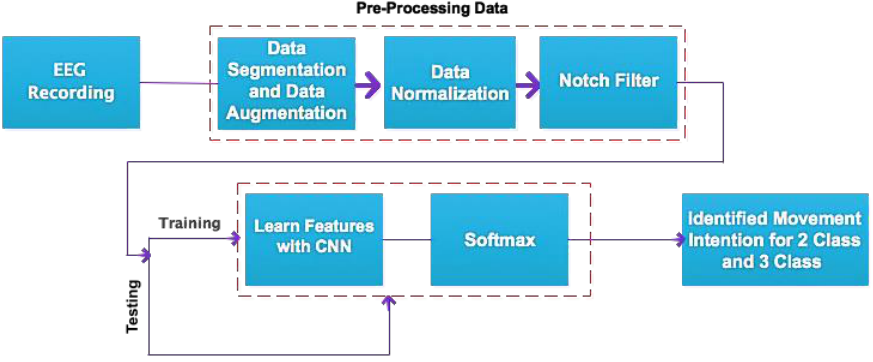
Figure 1. The block diagram of the proposed algorithm.